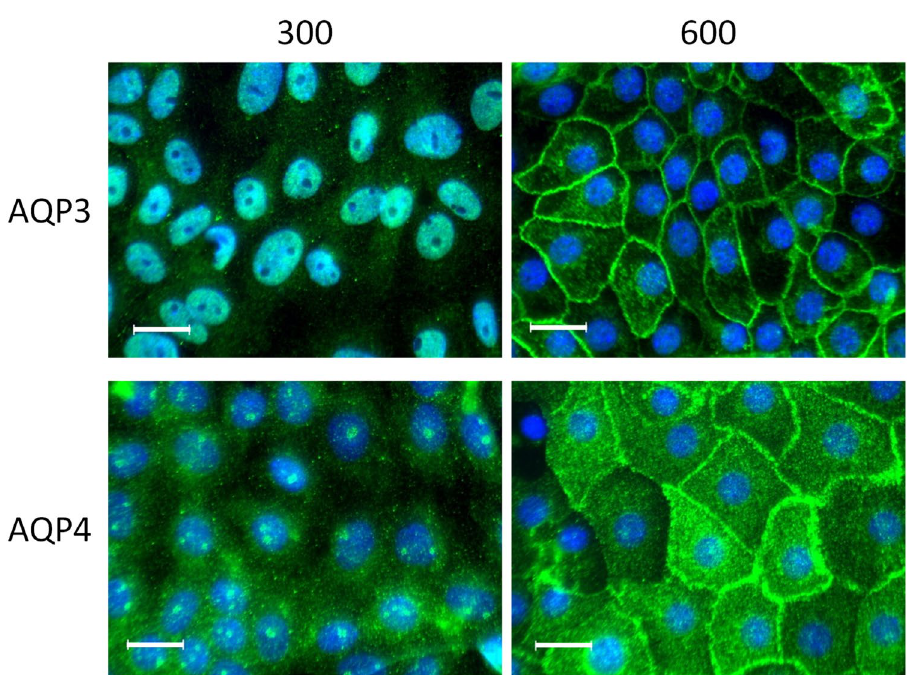
Figure 2. AQP3 and AQP4 are localized at plasma membrane. IMCD-cells were cultivated at 300 (right panel) and 600 mosmol/kg (left panel). AQP3 and AQP4 were detected using specific primary antibodies. Signals were detected using secondary Alexa-Fluor-488 labeled antibodies. The cell nucleus was stained with DAPI (blue). Images are representative for up to ten independent experiments. Scale bar, 20